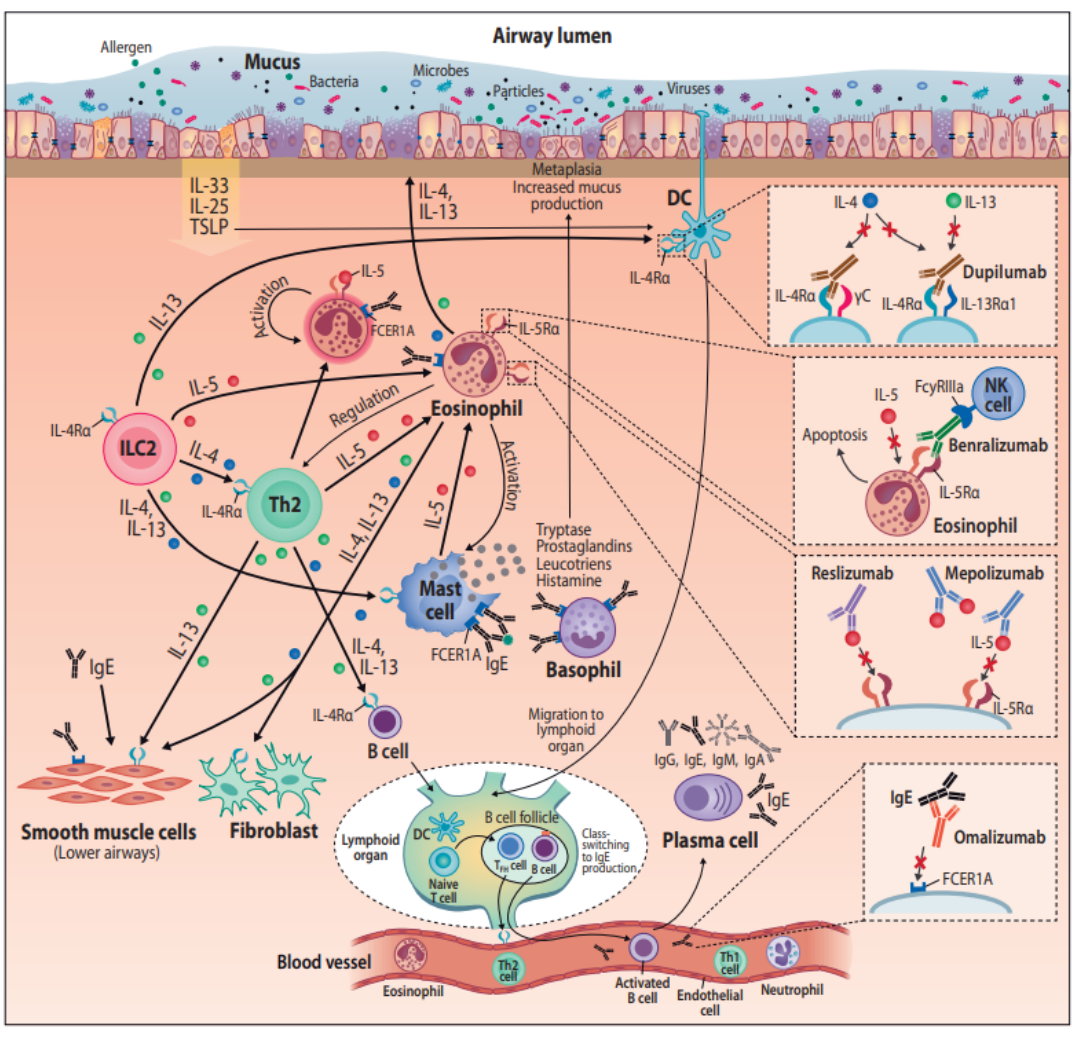
Figure 1. Monoclonal antibodies in the treatment of airway diseases, with their postulated